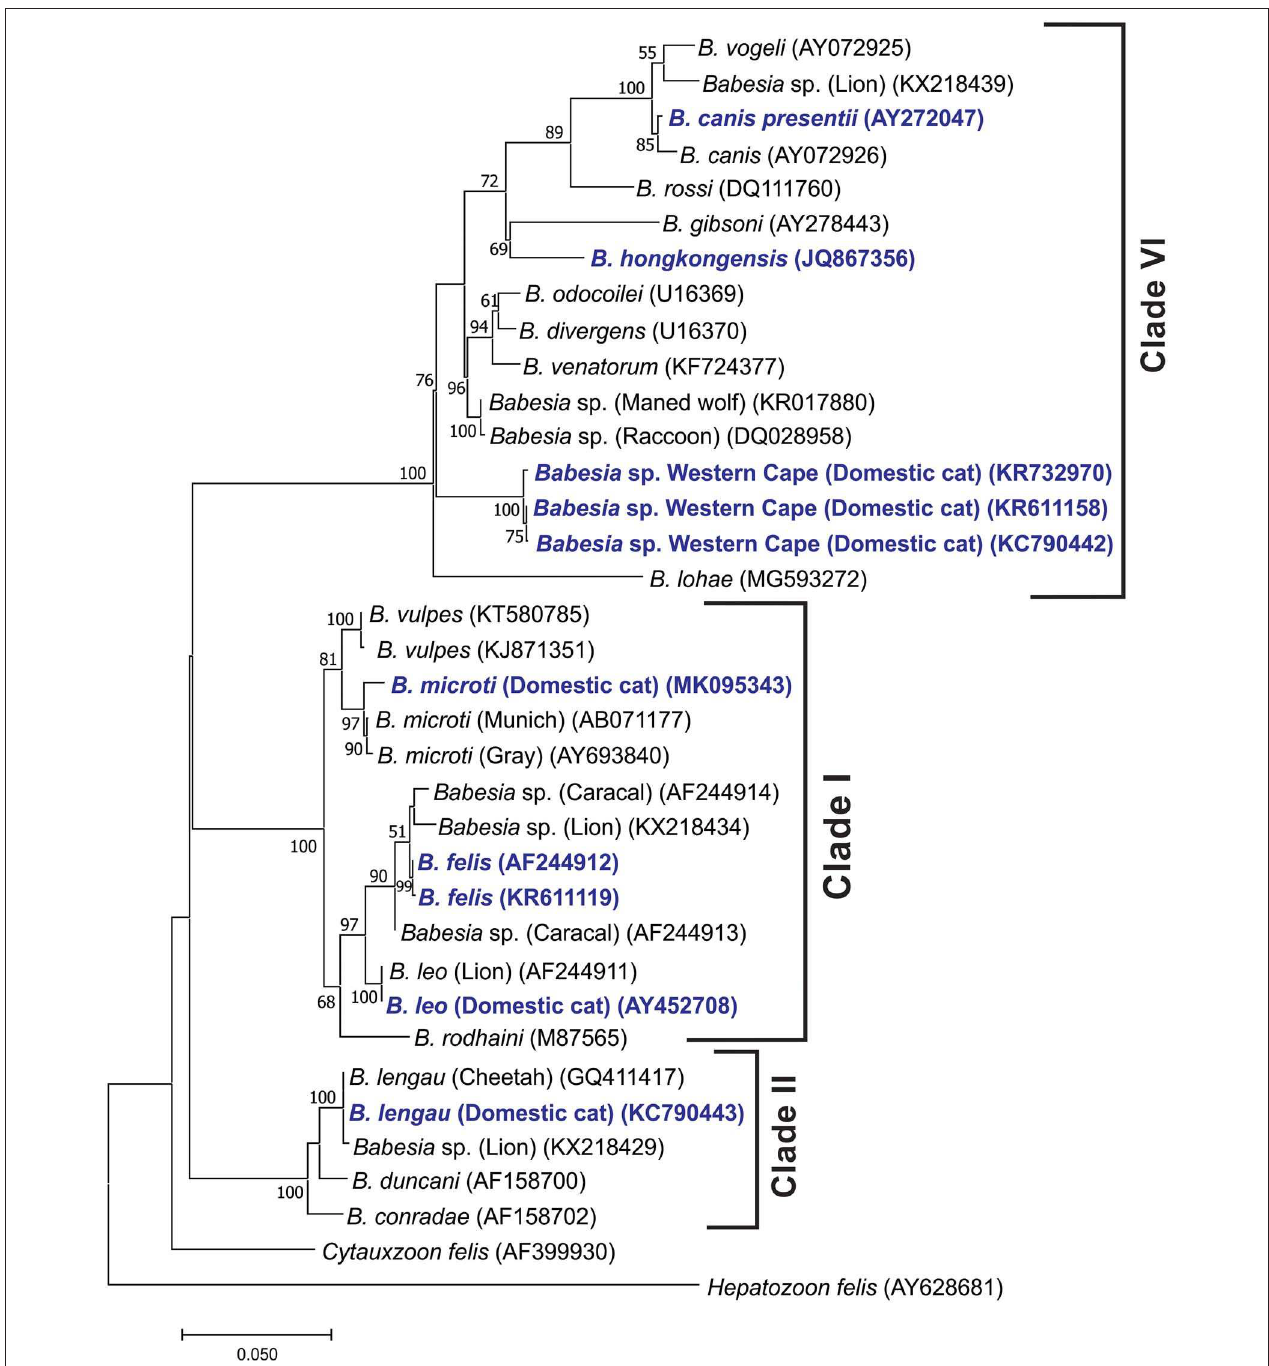
FIGURE 1 | Maximum likelihood tree showing the evolutionary relationships of the published near-full-length Babesia 18S rDNA sequences. Babesias described from domestic cats are indicated in dark blue. Sequence accession numbers are shown in parentheses. The evolutionary history was inferred by using the maximum likelihood method based on the Hasegawa–Kishino–Yano model (HKY + G + I) substitution model (59). The tree with the highest log likelihood ( − 6,143.13) is shown. The percentage of trees in which the associated taxa clustered together is shown next to the branches. Initial tree(s) for the heuristic search were obtained automatically by applying Neighbor-Join and BioNJ algorithms to a matrix of pairwise distances estimated using the maximum composite likelihood approach and then selecting the topology with superior log likelihood value. A discrete gamma distribution was used to model evolutionary rate differences among sites [five categories ( + G, parameter = 0.4871)]. The rate variation model allowed for some sites to be evolutionarily invariable [( + I), 55.35% sites]. The tree is drawn to scale, with branch lengths measured in the number of substitutions per site. All positions containing gaps and missing data were eliminated. There were a total of 1,351 positions in the final data set. Evolutionary analyses were conducted in MEGA7